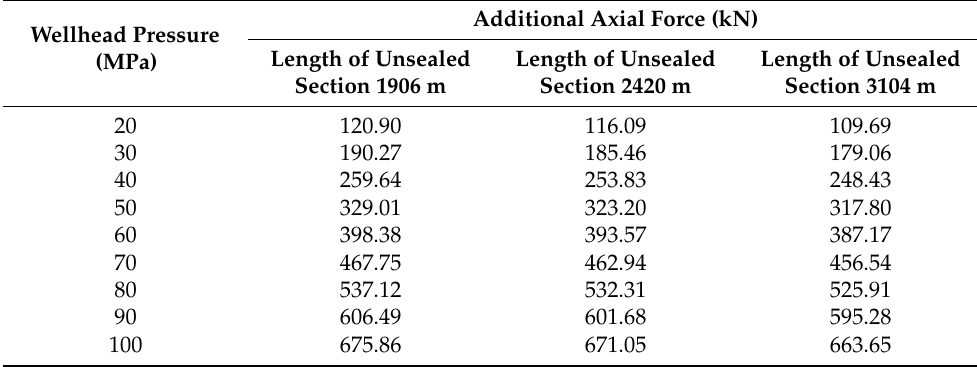
Table 2. Additional axial force of casing running in different length of unsealed